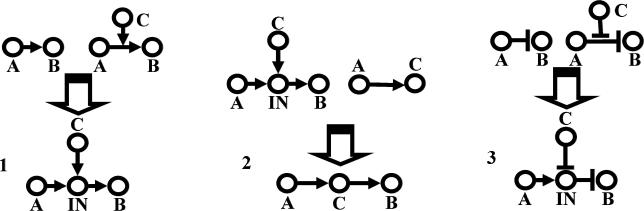
Illustration of the Inference Rules Used in Network Reconstruction(1) If A → B and C → process (A → B), where A → B is not a biochemical reaction such as an enzyme catalyzed reaction or protein-protein/small molecule interaction, we assume that C is acting on an intermediary node (IN) of the A–B pathway.(2) If A → B, A → C, and C → process (A → B), where A → B is not a direct interaction, the most parsimonious explanation is that C is a member of the A–B pathway, i.e. A → C → B.(3) If A —| B and C —| process (A —| B), where A —| B is not a direct interaction, we assume that C is inhibiting an intermediary node (IN) of the A–B pathway. Note that A→ IN —| B is the only logically consistent representation of the A–B pathway.